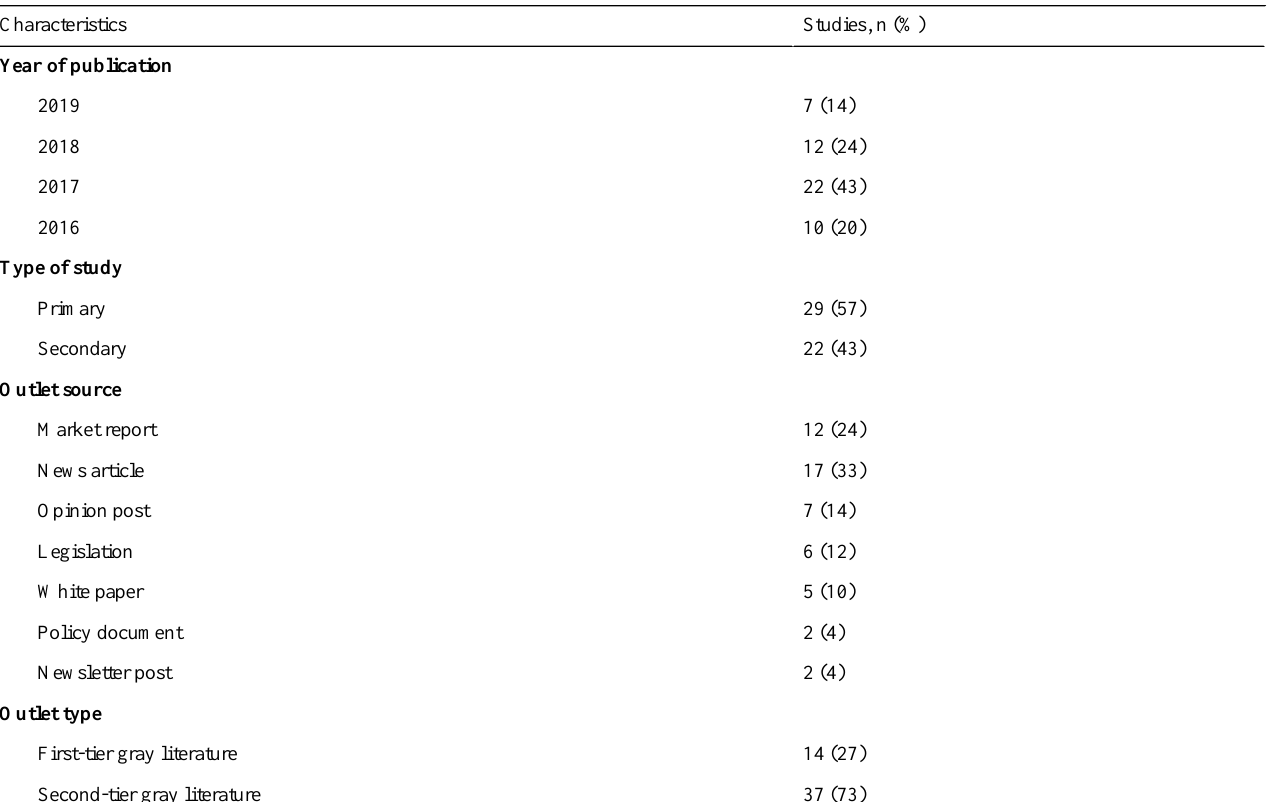
Table 1. Characteristics of the included gray literature (N=51).